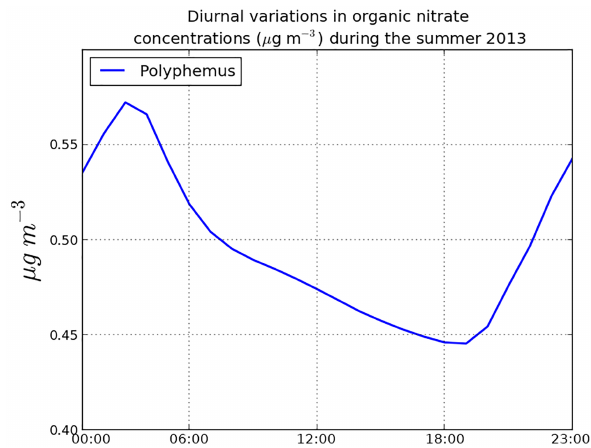
Figure 5. Diurnal variations in simulated organic nitrate concentra- tions during summer 2013 at